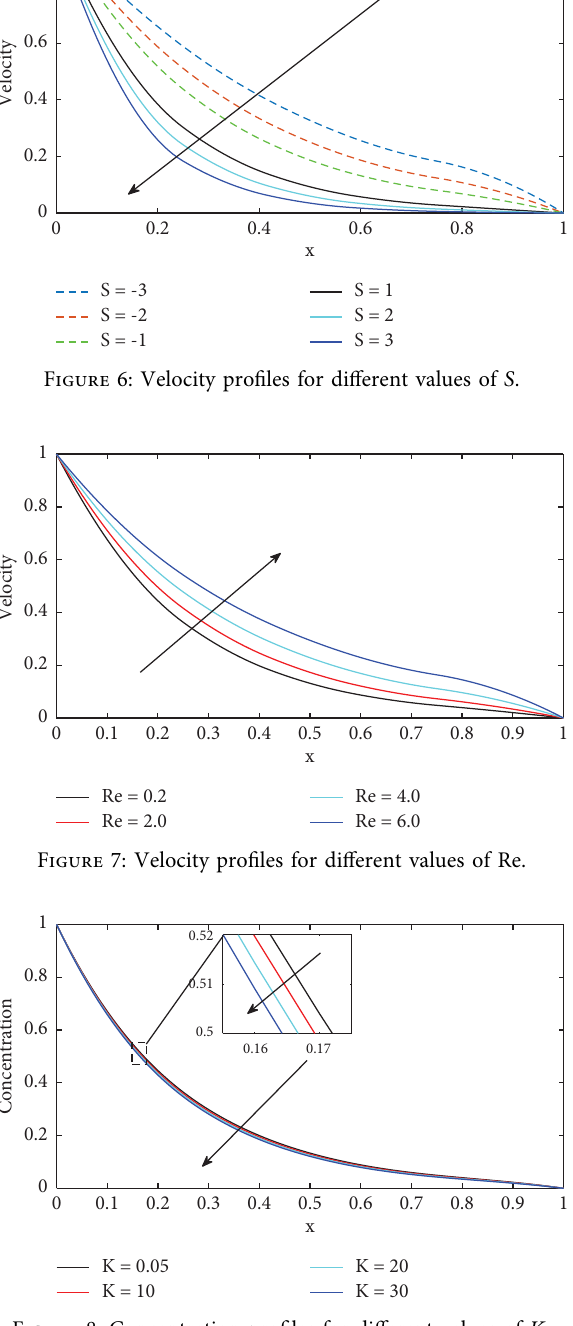
Figure 8: Concentration profles for diferent values of K